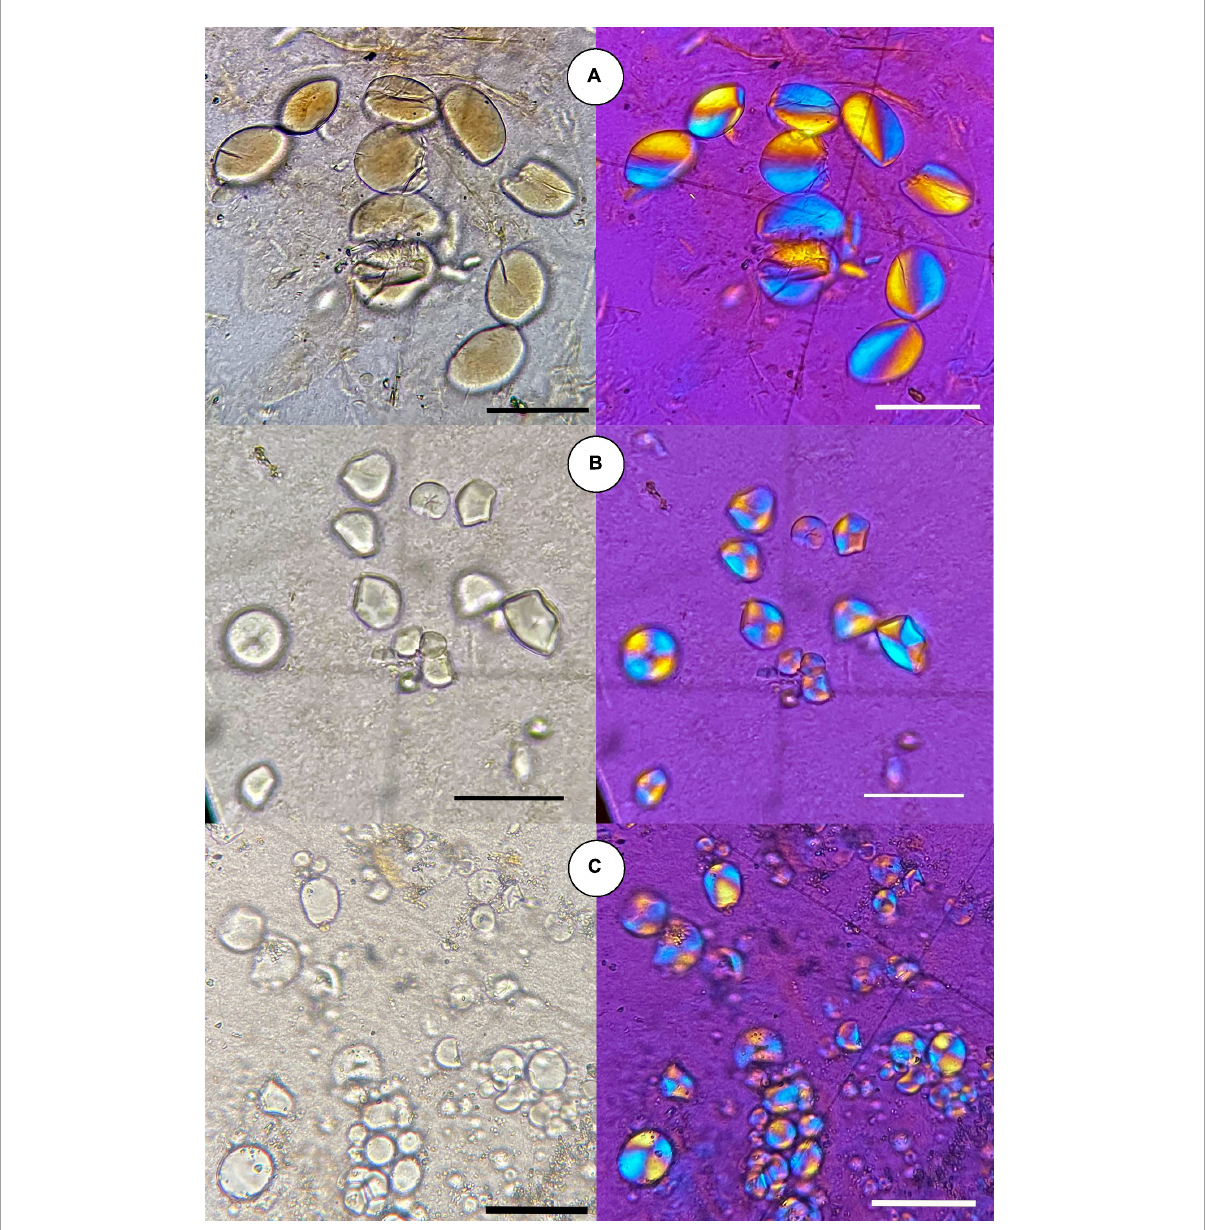
FIGURE3 Starch grains recovered from ancient macrobotanical remains from the Atacama Desert, northern Chile (each starch image is shown in DIC and polarized light): (A) achira ( C. indica ) grain from rhizomes from Az-11 (sample 001); (B) ahipa ( Pachyrhizus sp.) grain from tuberous roots from PLM-7 (sample 43501); (C) sweet potato ( I. batatas ) grain from tuberous roots from Az-71b (sample 27026). Scale bars: 10 µ